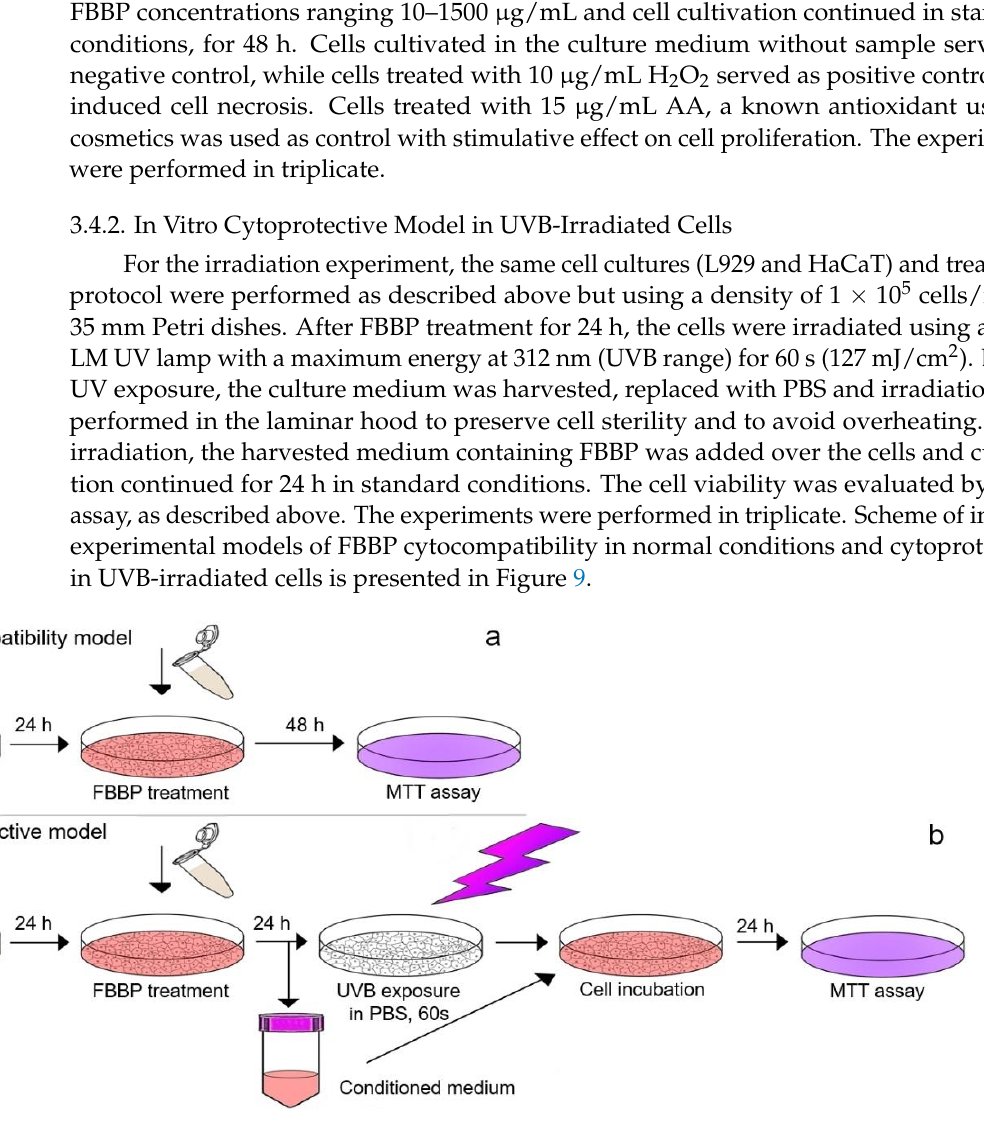
Figure 9. Schematic representation of in vitro experimental models developed for FBBP cytocompatibility testing in normal conditions ( a ) and cytoprotection in UVB-irradiated cells ( b ).